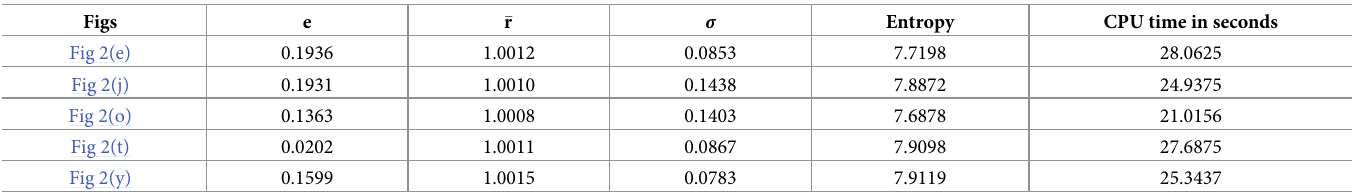
Table 1. Quantitative results of the model-M3 under e, � r , σ , entropy measure and CPU time for the de-hazed images of outdoor and indoor scenes.